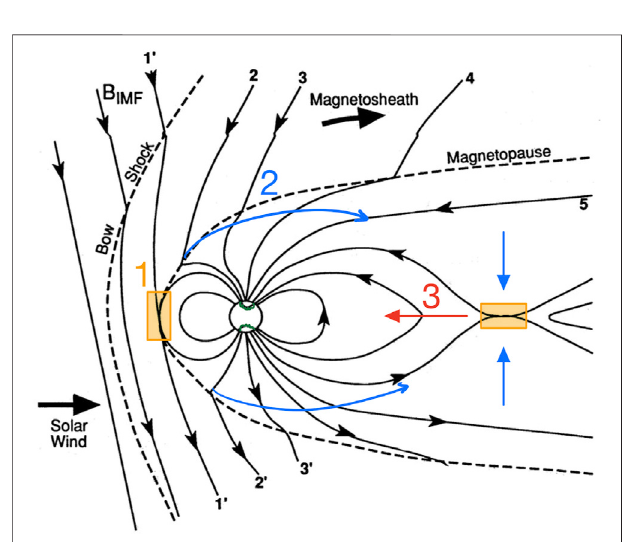
Earth ’ s magnetic fi eld and opening closed fi eld lines as shown in Figure 13 where magnetic reconnection occurs on the dayside magnetopause between the opposing magnetic fi eld lines of the solar wind ’ s IMF and the Earth ’ s magnetic fi eld.